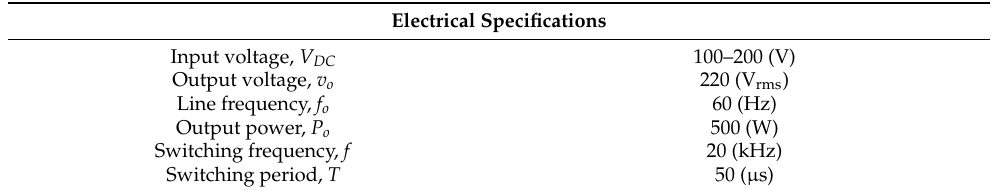
Table 2. Electrical specifications of the proposed high-gain inverter.